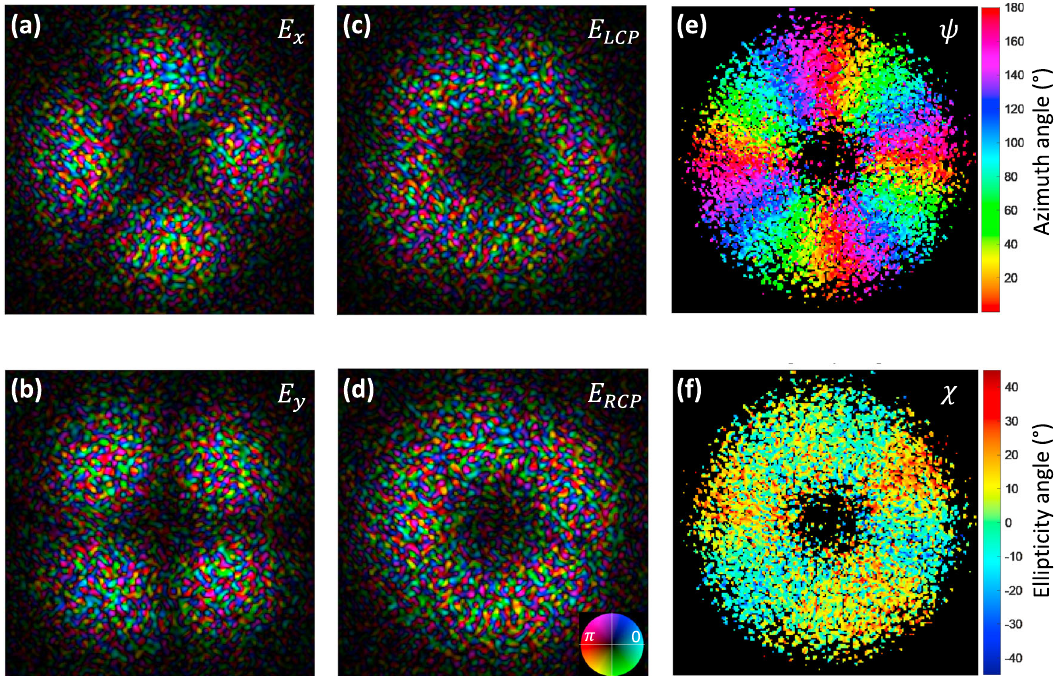
Fig. 5 Complex amplitude and polarization information of far fi eld as retrieved by the ptychographic measurement. Measured complex amplitude of a x -pol., b y -pol., c LCP, and d RCP components. The phase pro fi les for the four polarization components show typical speckle phase distributions. The inset fi gure in d is the color bar with phase encoded as hue and amplitude as brightness. Measured e azimuth angle and f ellipticity angle of polarization information.